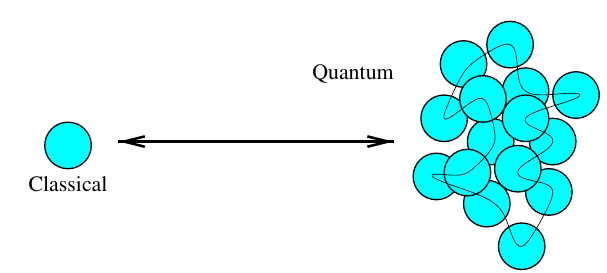
Figure 5. Path integral necklace of beads: each classical par- ticle is replaced by a ring of replicas connected by a harmonic interaction.